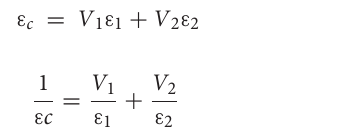
Relative permittivity ( ε r ) Measured Porosity value